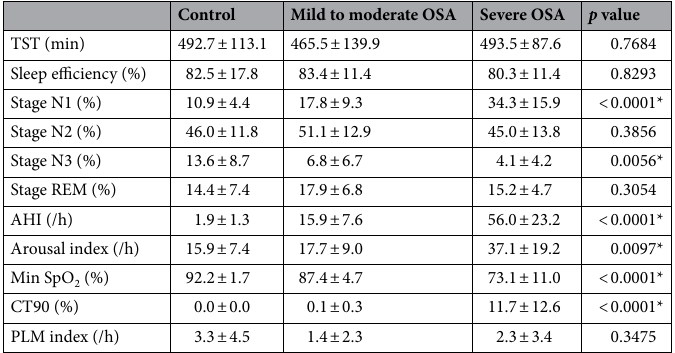
Table 2. Polysomnographic data. AHI, apnea-hypopnea index; CT90, percentage of cumulative time of blood oxygen saturation below 90% during sleep; Min SpO 2 , minimum saturation of percutaneous oxygen; OSA, obstructive sleep apnea; PSG, polysomnography; PLM, periodic limb movement; TST, total sleep time; *, p < 0.05.